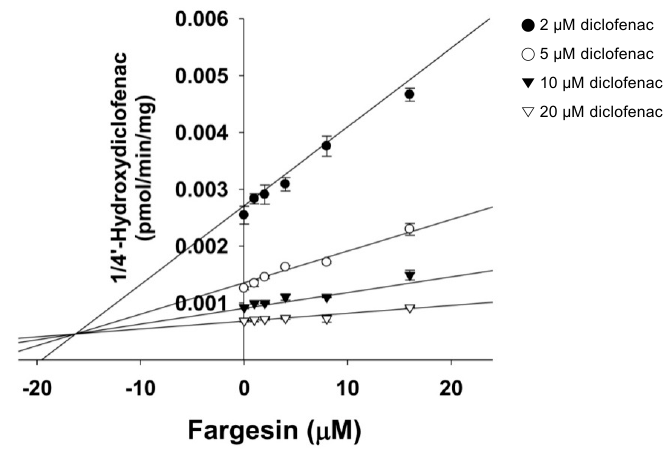
Figure 7. Dixon plot of the inhibitory effects of fargesin on CYP2C9-catalyzed diclofenac 4’-hydroxylation in pooled human liver microsomes. Data represent the average ± SD ( n = 3).